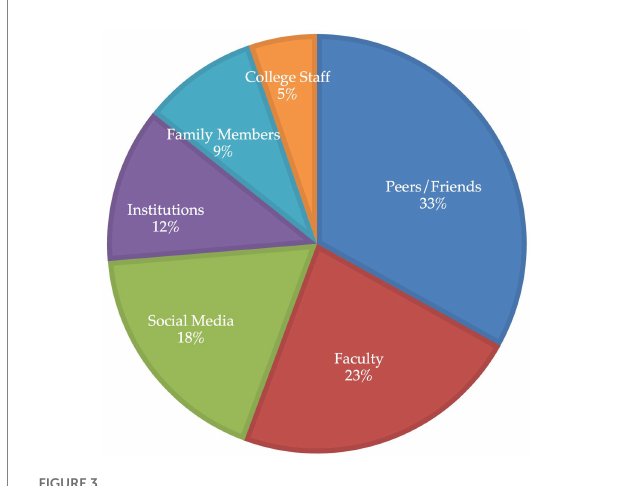
FIGURE 3 Support-system codes